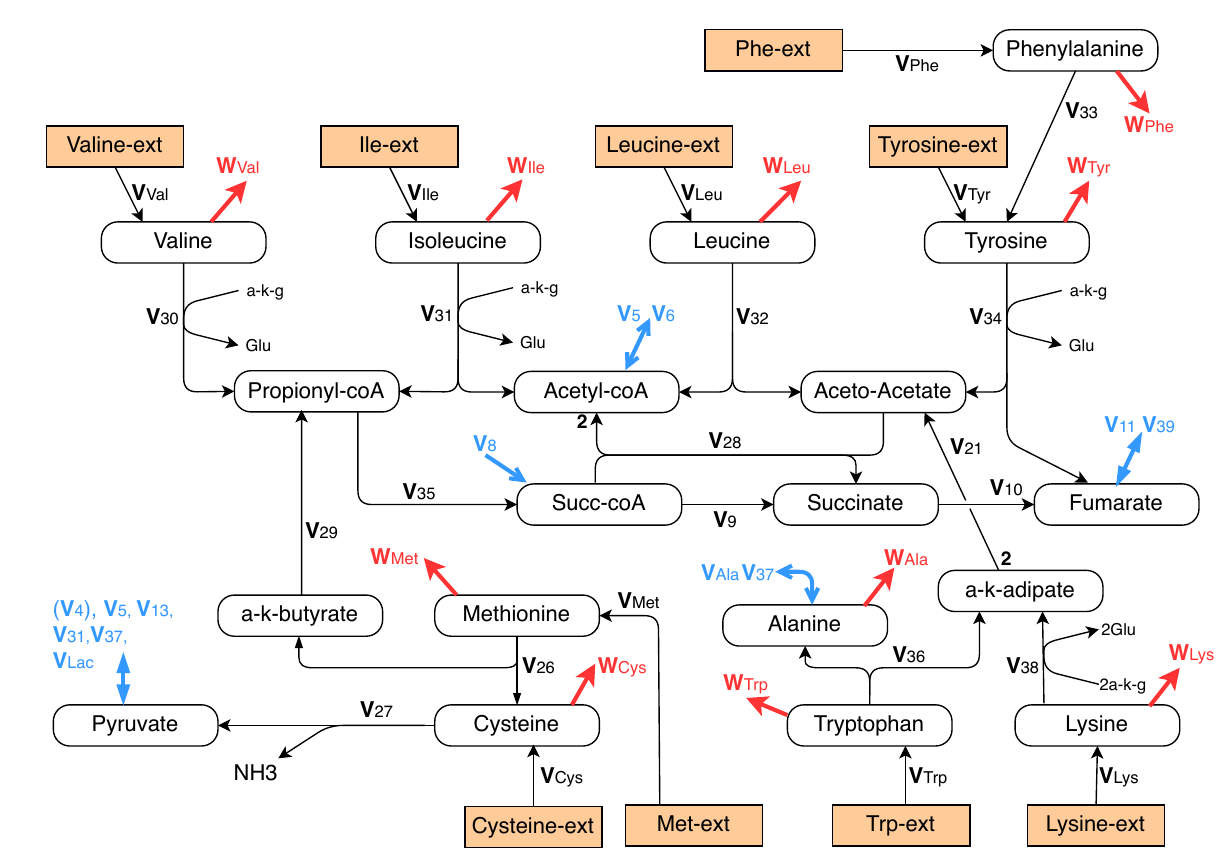
Figure 6. Metabolic network for seven essential amino acids (isoleucine, leucine, lysine, methionine, phenylalanine, tryptophan, valine) and two non-essential amino acids (cysteine, tyrosine).